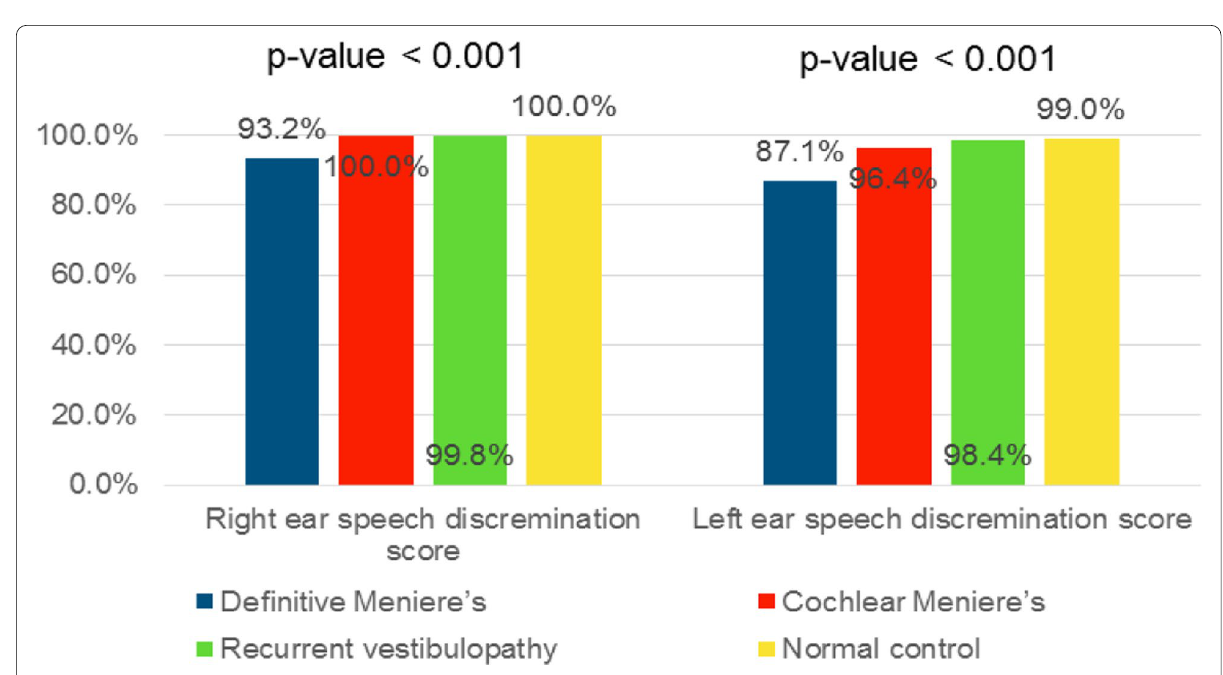
Fig. 4 Percentage of speech discrimination